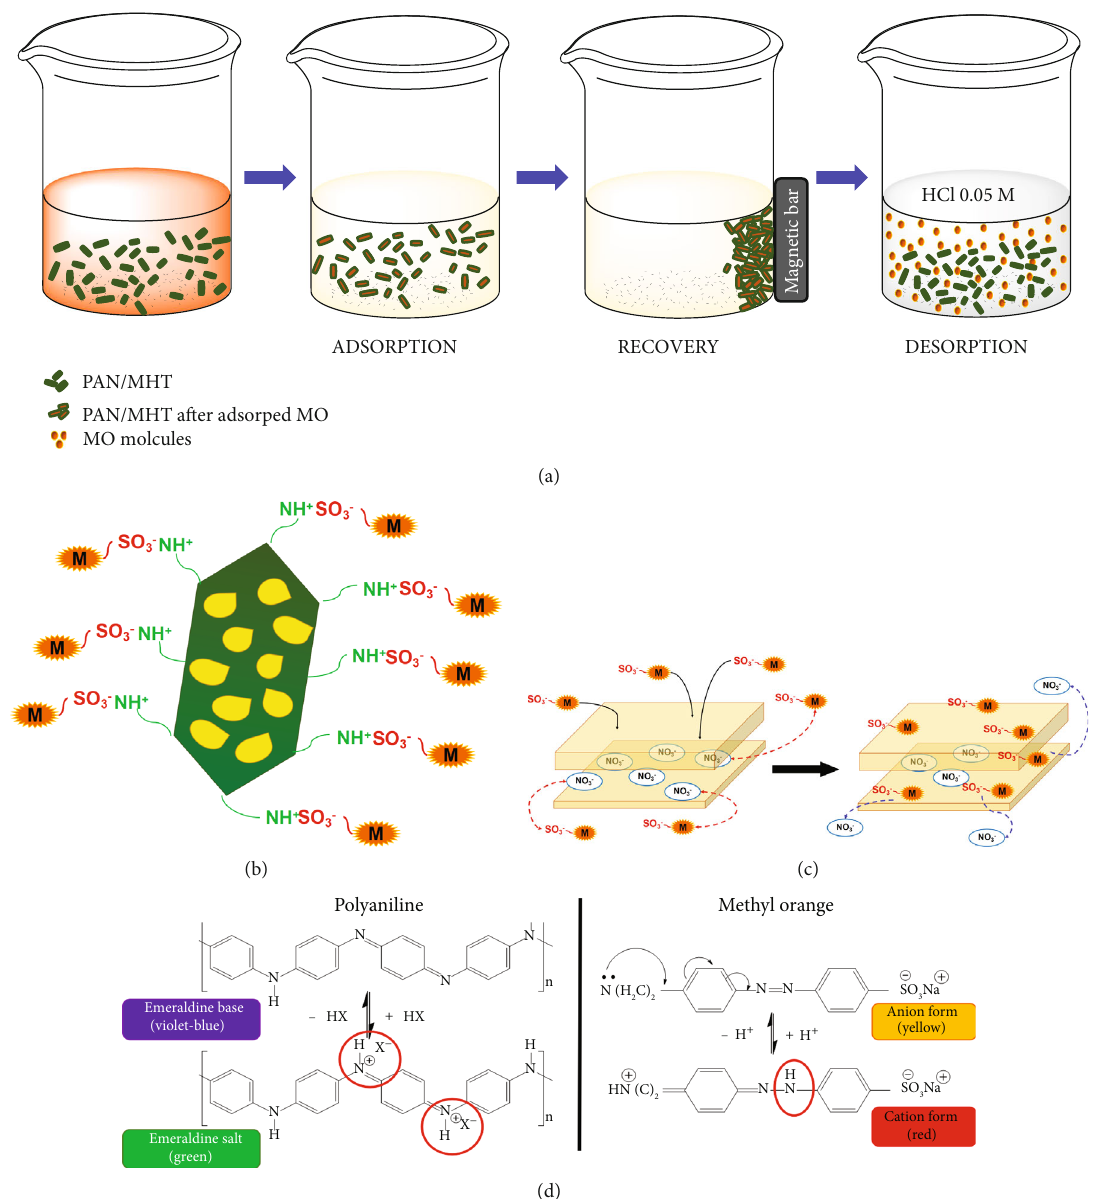
Figure 17: Schematic illustration of the adsorption and desorption mechanism of MO on